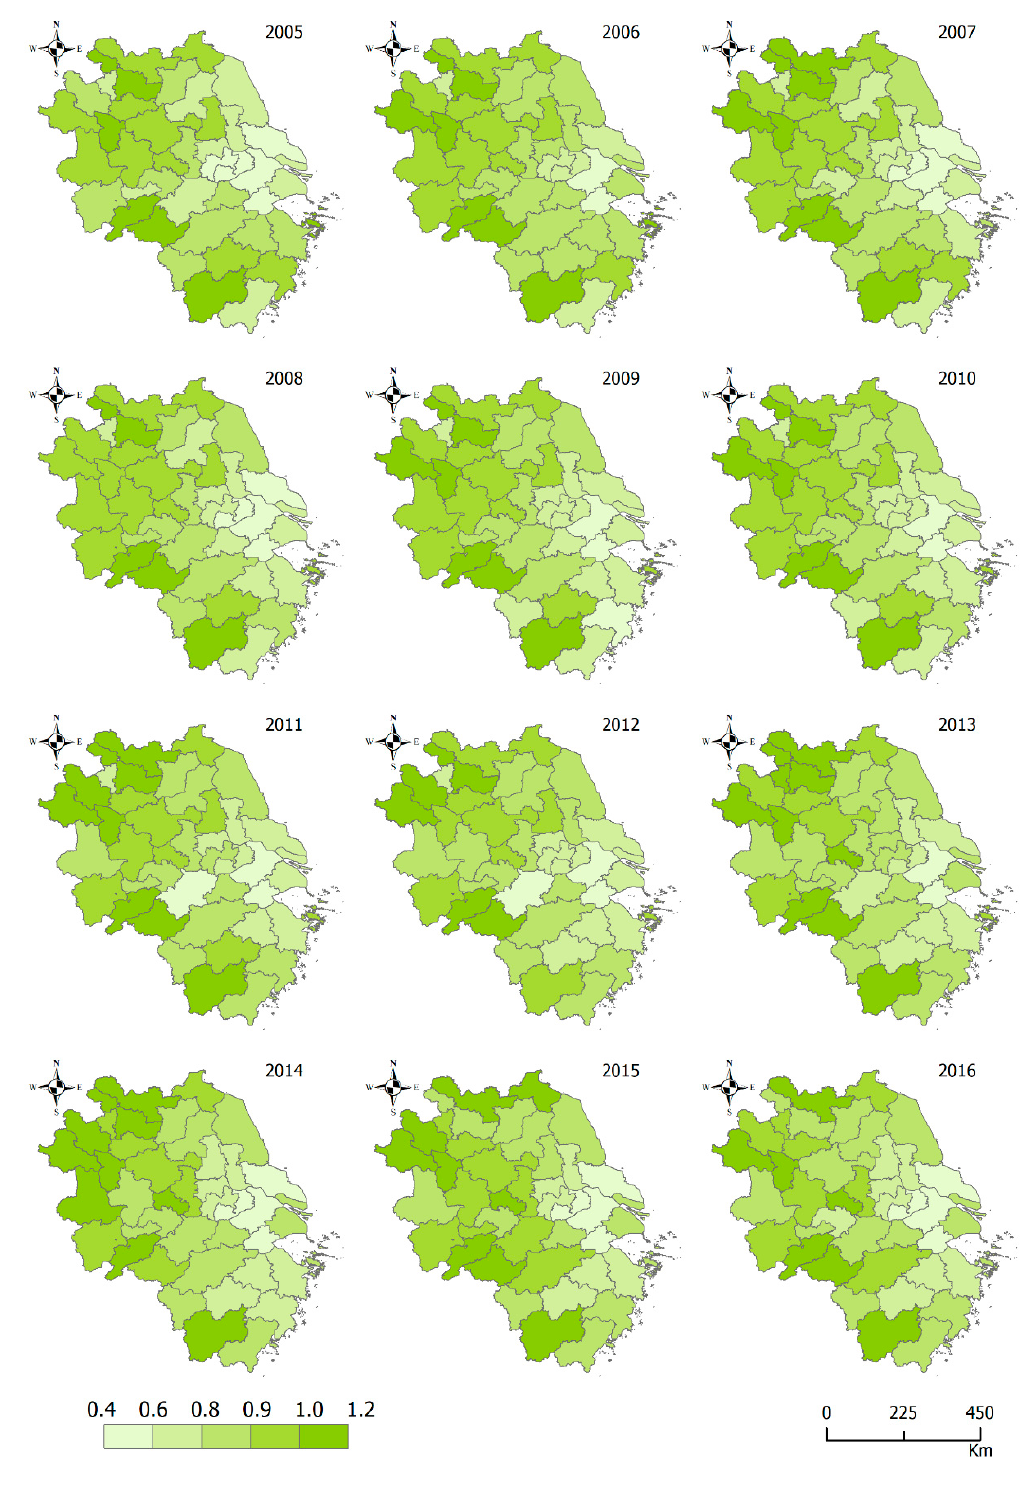
Figure 6. Spatiotemporal distribution of RV.